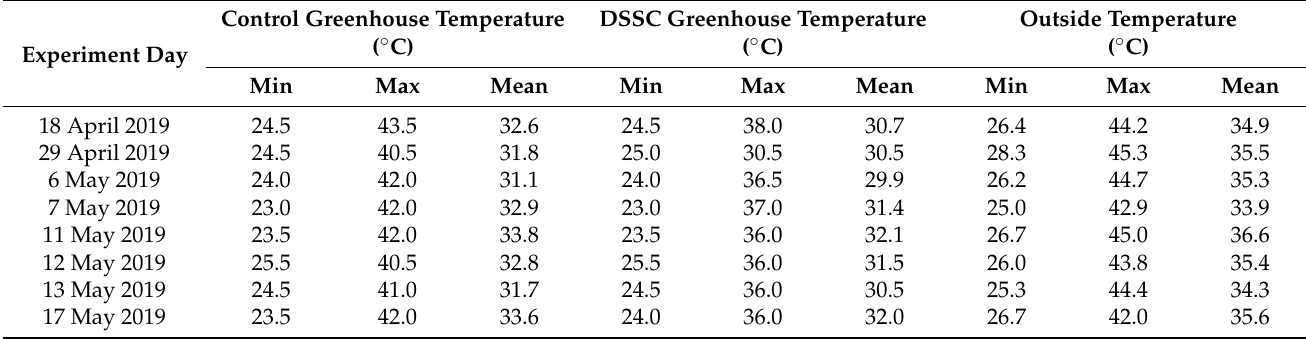
Table 3. Lowest, highest, and mean air temperature readings for outside and within the DSSC and control (glass) greenhouses. Experiment Day